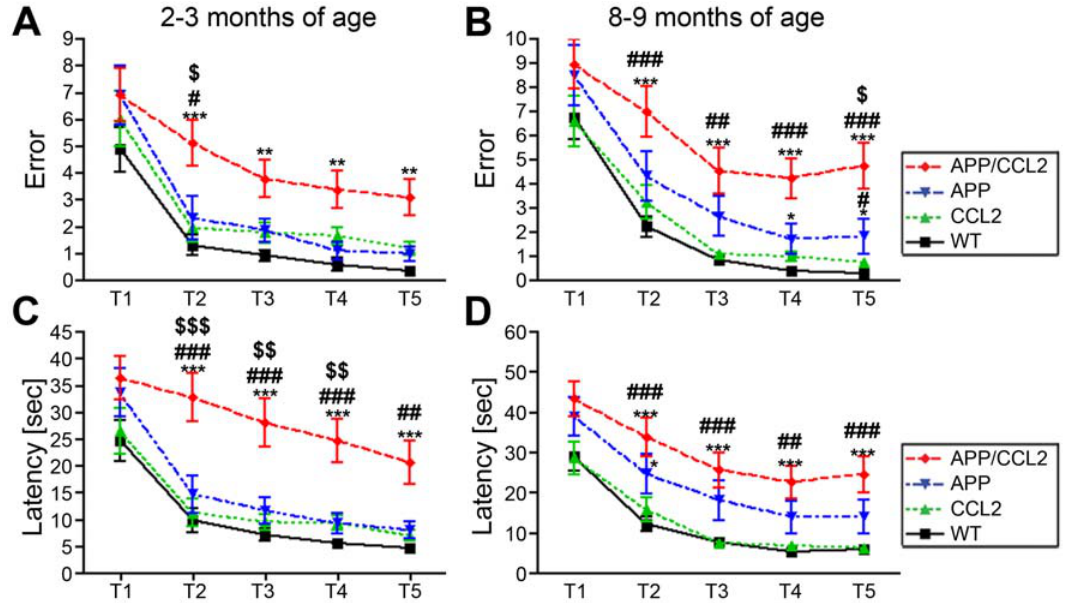
Figure 1. Accelerated spatial learning impairment in APP/CCL2 mice. The same animals were tested by RAWM test at two different time points: 2–3 (A and C) and 8–9 months of age (B and D). The numbers of animals were 9 APP/CCL2, 10 CCL2, 8 APP, and 10 WT mice (all littermates from cross breeding of APP and CCL2 hemizygotes). The compiled average errors (A and B) and latency (C and D) of Trial 1-5 are shown. *, ** or *** denotes p , 0.05, 0.01 or 0.001 versus WT, # , ## or ### denotes p , 0.05, 0.01 or 0.001 versus CCL2, and $ , $$ or $$$ denotes p , 0.05, 0.01 or 0.001 versus APP group, respectively, as determined by two-way ANOVA and Bonferroni posttests.